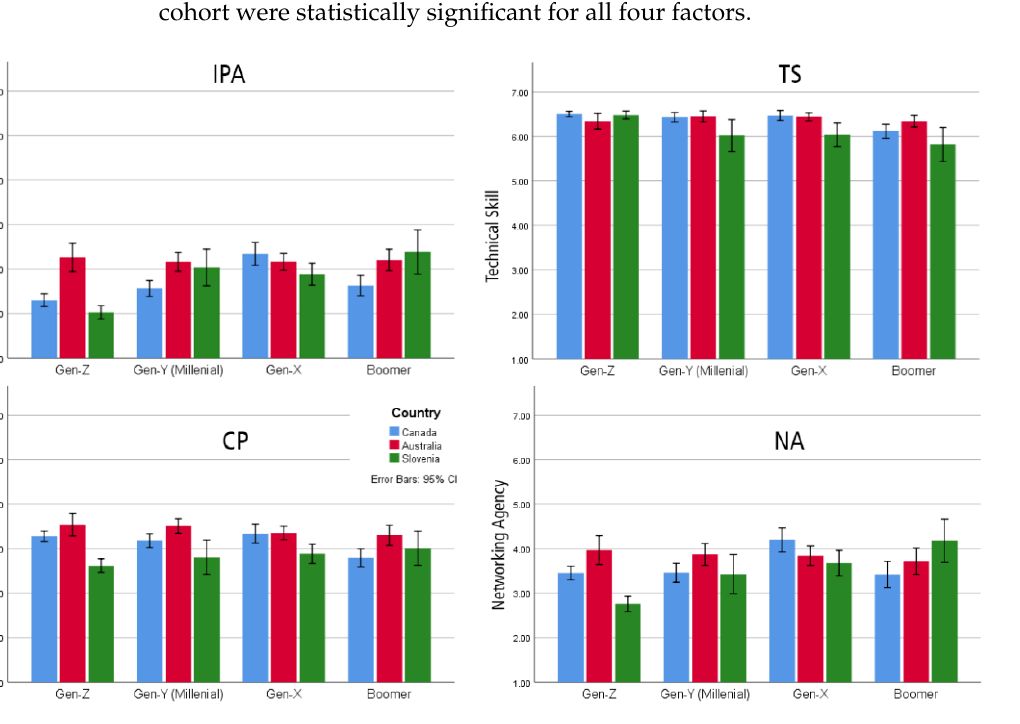
Figure 2. Generation and Nationality Across all Four Factors. Table 6. Summary of ANOVA results of nationality and generation on DCS-R factors.